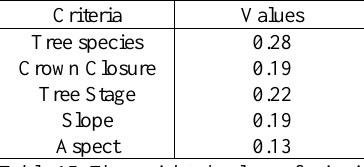
Table 15. The weighted values of criteria Figure 7 indicates the distribution of forest fire risk map with respect to all the criteria. Based on the GIS-based AHP